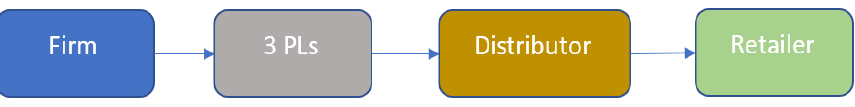
Figure 1. Multi-Echelon downstream supply chain.